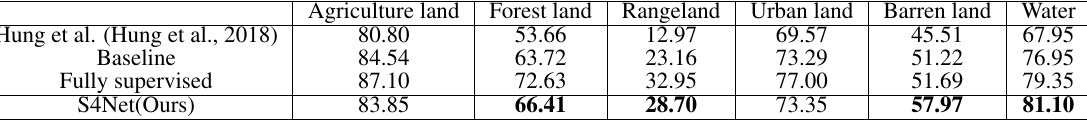
Table 3. The detailed per-class performance of our method and other methods.